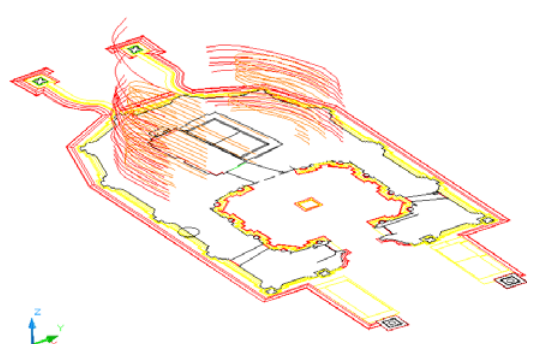
Figure 7: All the polylines referenced to a horizontal section of the Holy Aedicule.